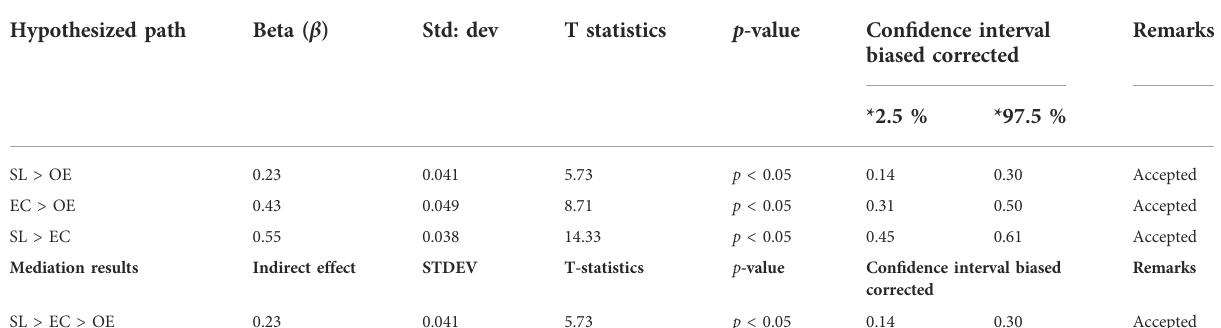
TABLE 4 Path coef fi cients ( β ) and T-statistics.